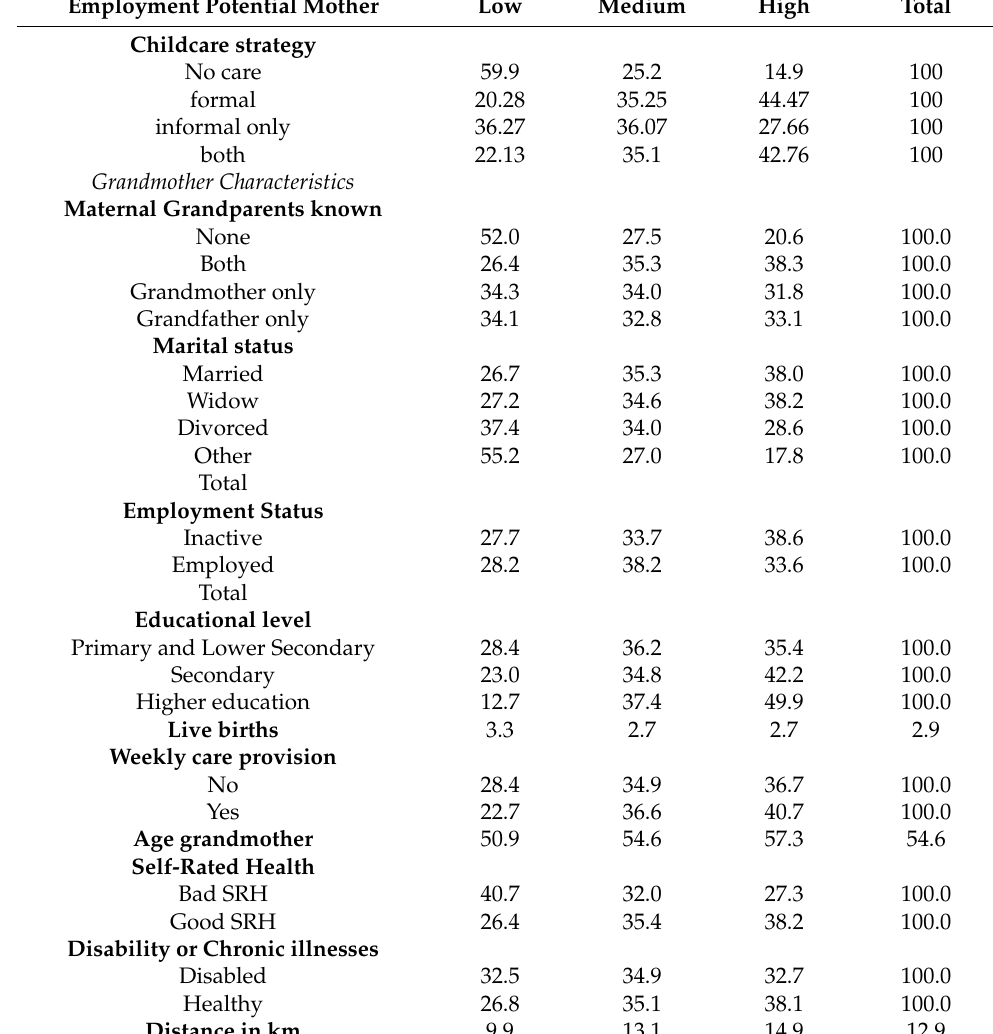
Table A1. Descriptive statistics by estimated employment probability of the mother, row